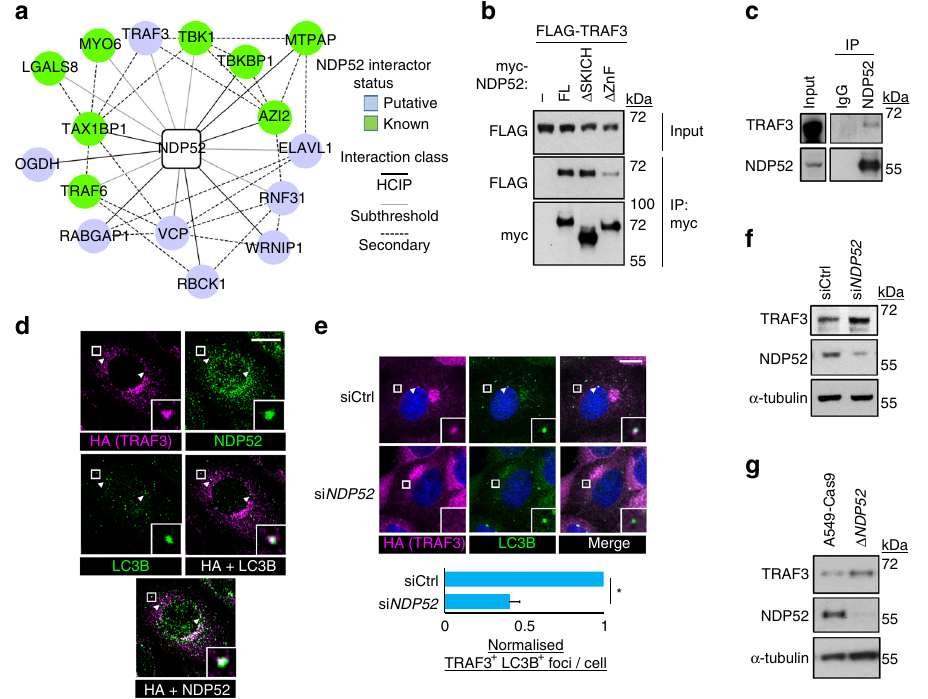
Fig. 3 Autophagic degradation of TRAF3 via the cargo receptor protein NDP52. a FLAG-HA-NDP52 was used as bait for co-immunoprecipitation LC-MS/ MS from A549 cells. Hits were identi fi ed using CompPASS thresholding for high-con fi dence interacting proteins (HCIPs) and by inclusion of immediate subthreshold interactors on the proviso of known secondary interaction with at least two HCIPs (BioGRID). Known interactors of NDP52 were equally distributed among HCIP and subthreshold hits. b HEK293T cells were co-transfected with FLAG-TRAF3 and either empty vector ( − ) or myc-tagged forms of NDP52 (full-length, FL, or deletants of the N-terminal SKICH domain, Δ SKICH, or C-terminal Zinc Fingers, Δ ZnF). Anti-myc immunoprecipitation (IP) was performed followed by immunoblotting. c A549 lysates were immunoprecipitated with anti-NDP52 antibody-conjugated beads or control rabbit IgG beads and immunoblotted. d A549 cells stably expressing FLAG-HA-TRAF3 were stained for indicated epitopes and analysed by confocal microscopy ( scale bar = 10 µ m). LC3B and NDP52 are both false-coloured green and are overlaid separately with magenta HA (TRAF3) in merge panels. Arrowheads indicate co-localising foci. Boxes correspond to zoomed insets . e A549 cells expressing FLAG-HA-TRAF3 were transfected with the indicated siRNA for 72 h and then cells were stained for confocal microscopy ( scale bar = 10 µ m). Arrowheads indicate dual foci of TRAF3 and LC3B, quanti fi ed on a per cell basis (means, n = 3, ± S.E.M., * P < 0.05, two-tailed t -test). f A549 cells were transfected with siCtrl or si NDP52 for 72 h and immunoblotted as shown. g A549- Cas9 control cells or pooled Δ NDP52 counterparts were immunoblotted as shown. Uncropped blots are available in Supplementary Fig.